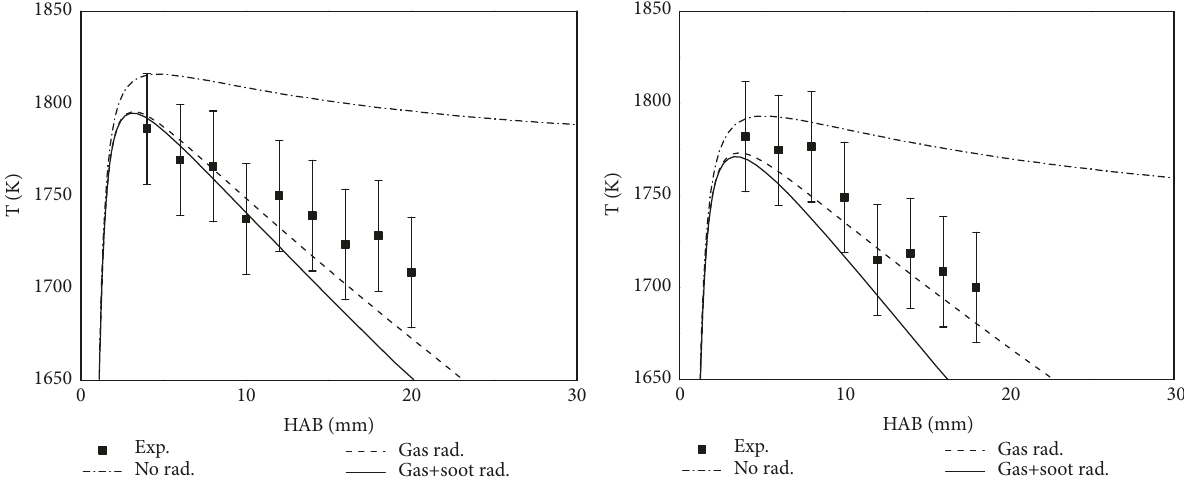
Figure 3: Comparison of flame temperatures for 𝜙 = 1.8 (left) and 2.0 (right) at exit velocity V = 8.8 cm/s.